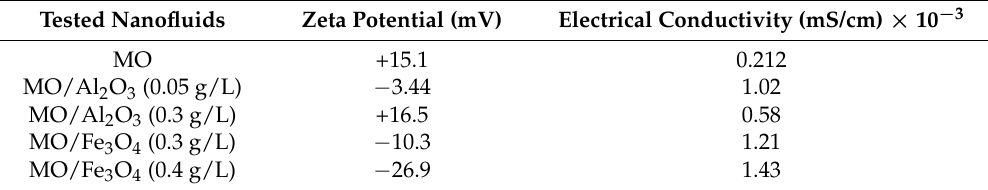
Table 2. Zeta potential and electrical conductivity of the tested nanofluids.